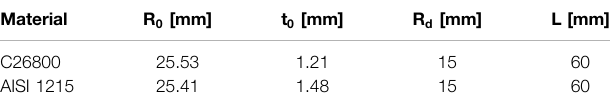
TABLE 2 | Geometry parameters of the tube.